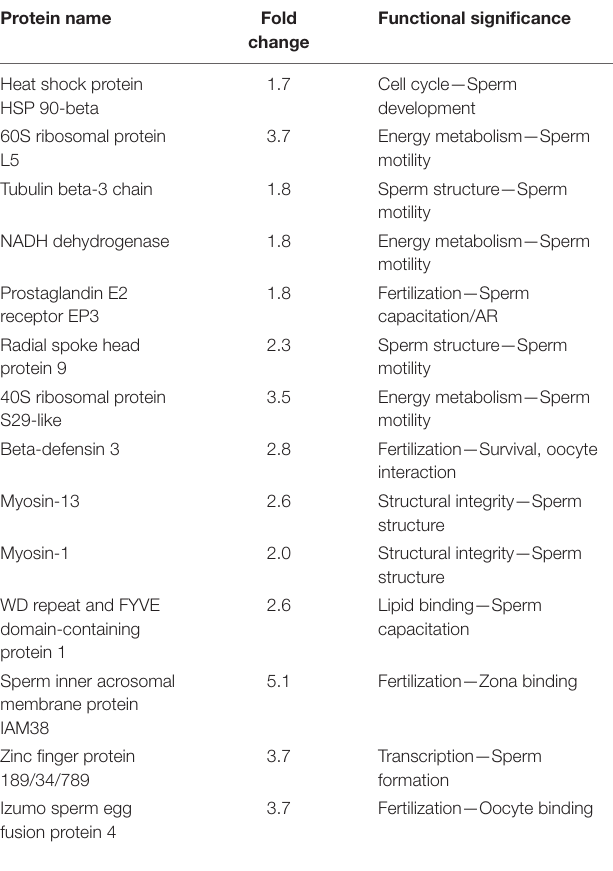
TABLE 3 | Important sperm proteins downregulated in crossbred bull spermatozoa and indigenous bull spermatozoa (from Aslam, 2014; Aslam et al.,